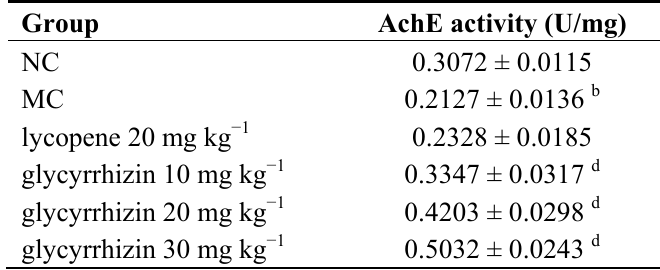
Table 5. Effect of glycyrrhizin treatment on AchE activity in nasal mucosa.